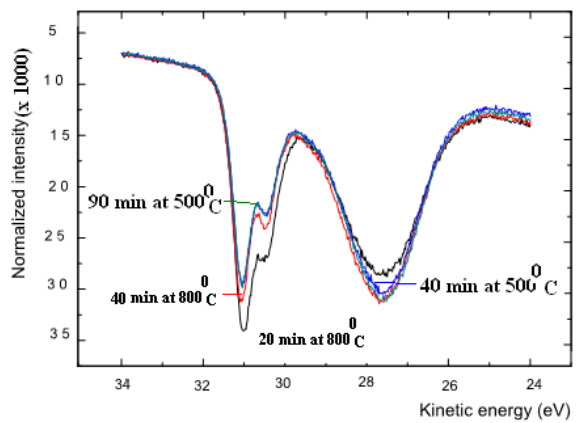
Fig 2: Si 2p spectra of Si(100) after exposure to 300- 2100L total